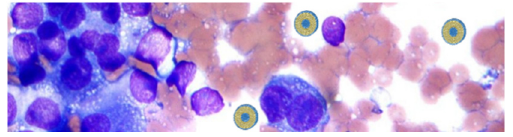
Figure 3. Liposomes internalization into melanoma cells.